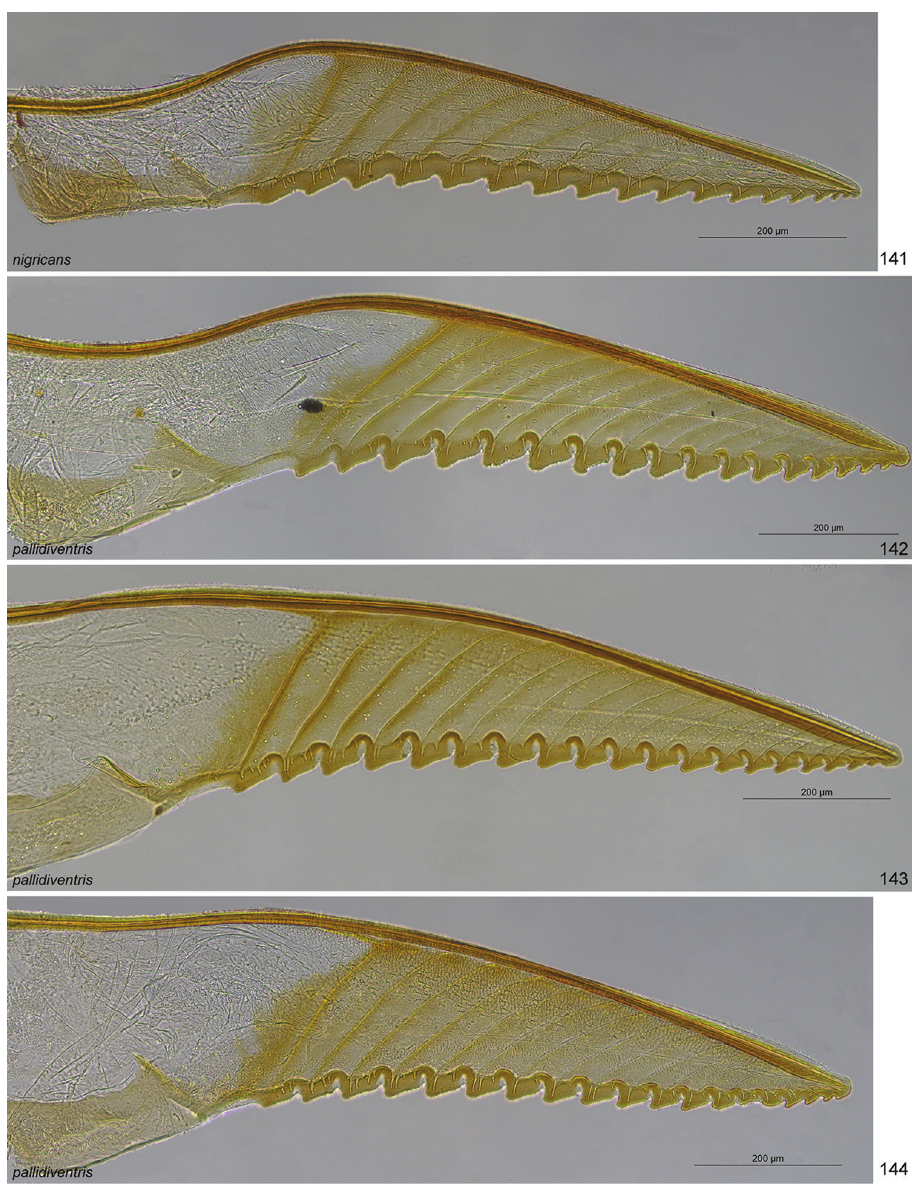
Figures 141–144. Lancets of Pristiphora . 141 nigricans DEI-GISHym20619 142 pallidiventris DEI- GISHym20667 143 pallidiventris W8473 144 pallidiventris